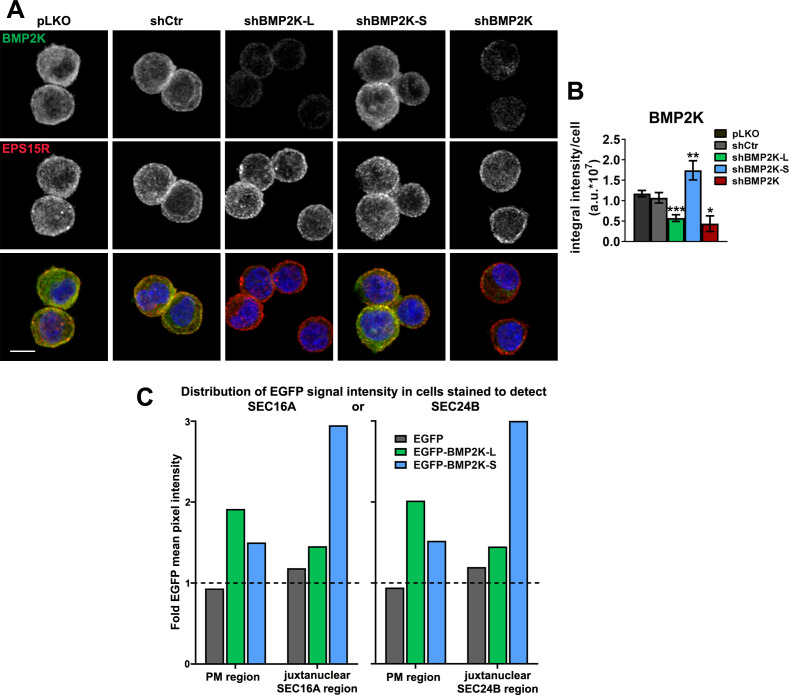
The analysis of intracellular distribution of BMP2K variants.(A) Representative maximum intensity projection images from confocal microscope showing intracellular localization of endogenous BMP2K with respect to endogenous EPS15R in K562 cells depleted of single (shBMP2K-L or shBMP2K-S) or all BMP2K splicing variants (shBMP2K), as compared to empty pLKO vector or non-targeting shRNA construct, shCtr. Cell nuclei marked with DAPI stain (blue). Scale bar, 10 µm. (B) Integral fluorescence intensity of BMP2K staining, shown as arbitrary units (a.u.) per cell, quantified from microscopic images of cells depleted of BMP2K splicing variants as represented by those in A (n = 4 +/- SEM). Values in cells depleted of BMP2K variants were compared statistically to the levels in cells treated with shCtr. (C) Mean pixel intensity of EGFP fluorescence signal in the indicated cell regions (plasma membrane, PM, or juxtanuclear) shown as fold change over mean intensity in the remaining cell area (represented by dashed horizontal line). Quantification performed based on images of cells represented in Figure 2C: transduced with EGFP only, or EGFP-tagged BMP2K variants and stained using antibodies detecting SEC16A or SEC24B proteins (n = 1, >4000 cells/condition). *p<0.05, **p<0.01, ***p<0.01.Figure 2—figure supplement 2—source data 1.Numerical data for graphs in Figure 2—figure supplement 2.